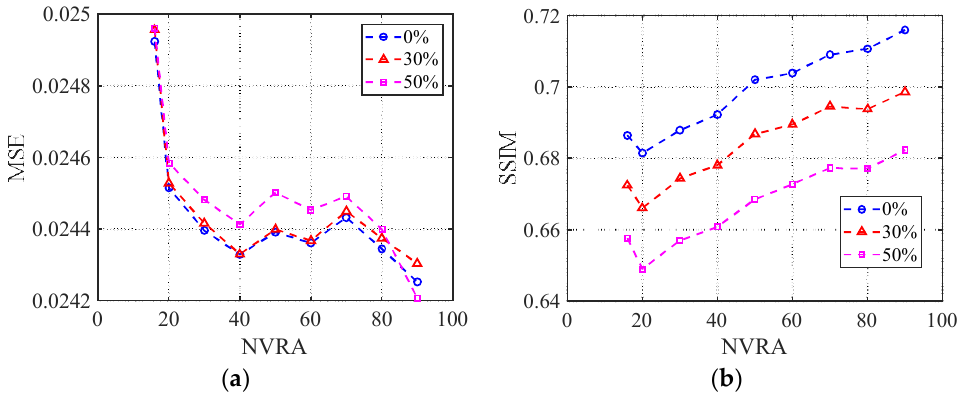
Figure 5. Changing curves of MSE and SSIM versus NVRA under different noise levels: ( a ) MSE; ( b ) SSIM. Table 2. Statistical results of MSE and SSIM using different scattered field matrices for inversion under different noise levels.